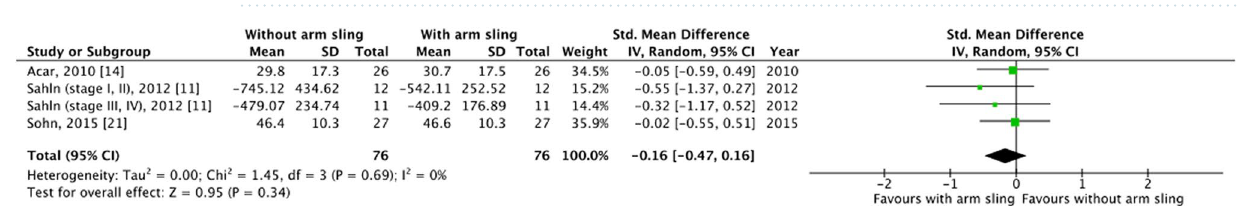
Figure 3. Forest plot for walking speed comparison, weighted mean difference.